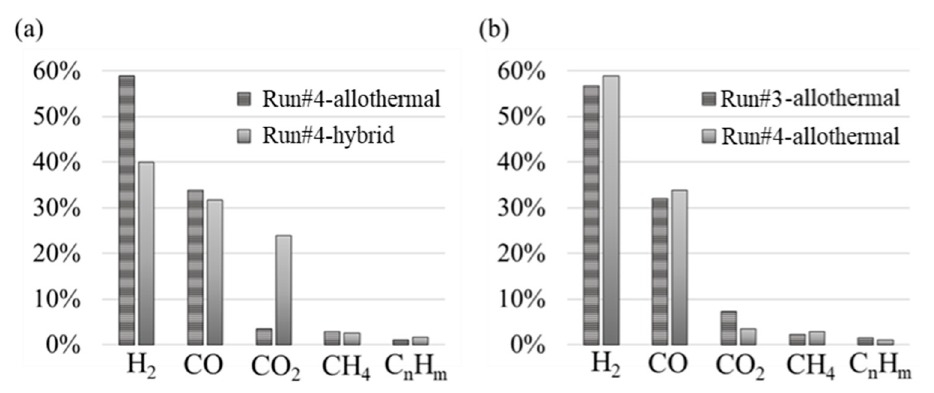
Figure 9. Reactor temperatures in Run#3 (solar-only) and Run#4 (both solar and solar-hybrid).